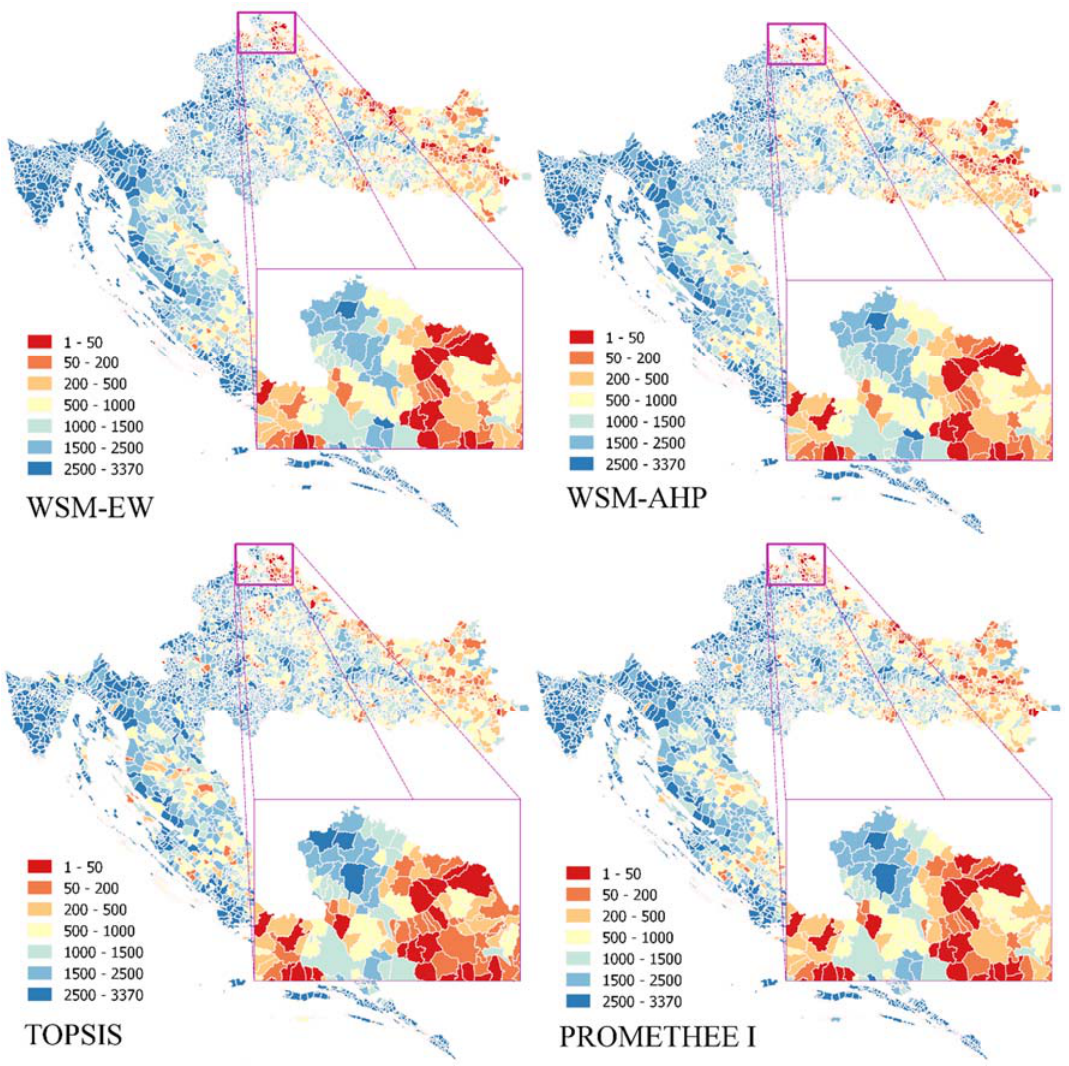
Figure 7. Ranking results thematic map.